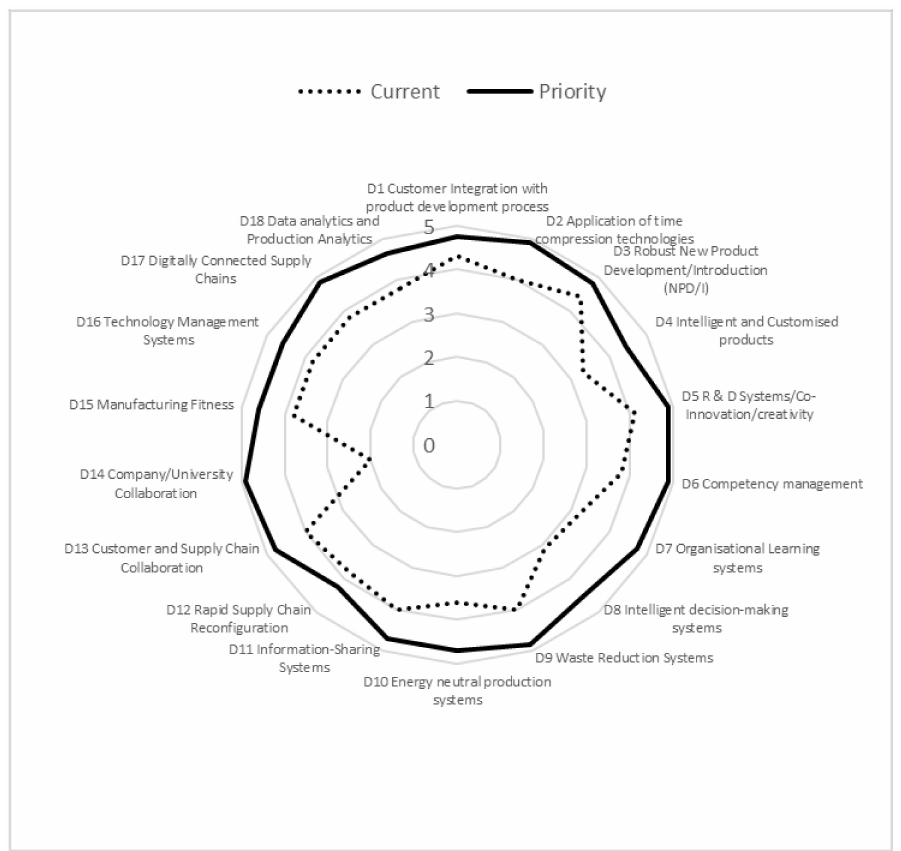
Figure 7. The analysis of current and future profiles of SMEs with 10–50